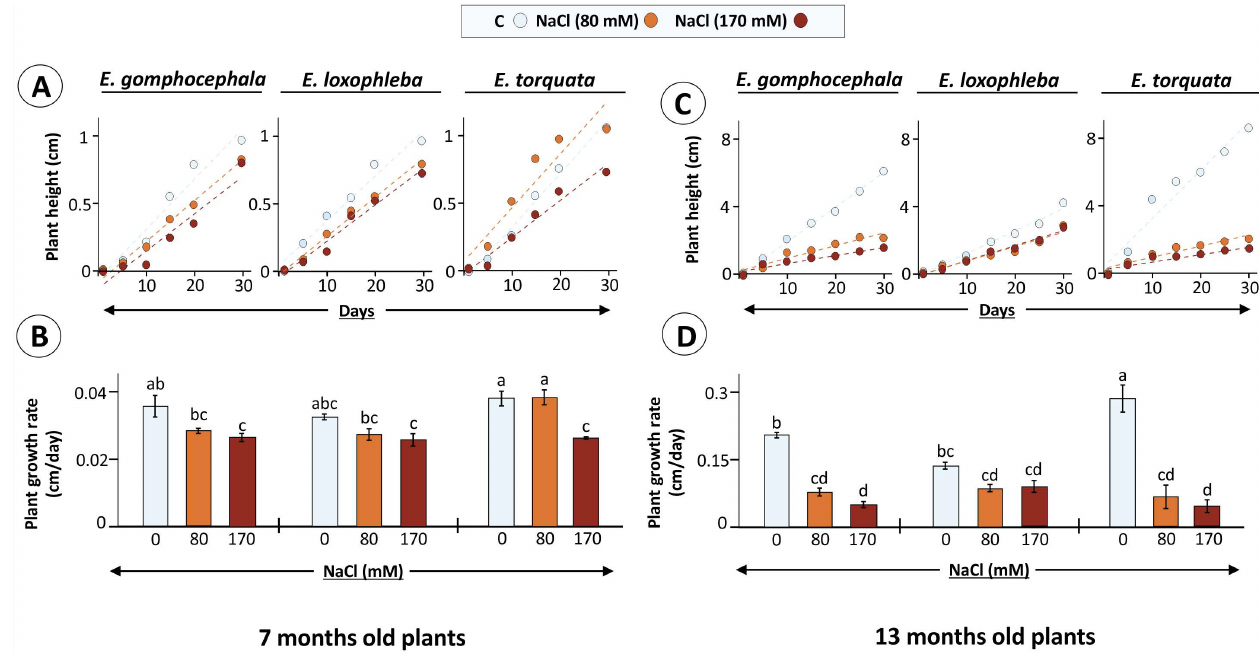
Figure 2. Eucalyptus plant growth as influenced by salt treatment. Eucalyptus species were exposed to NaCl (80 and 170 mM) added to the growth substrate after 6 ( A , B ) or 12 ( B , C ) months after germination and their growth was recorded during next 30 d. In ( B , D ), data are means of plant growth rate ± SE ( n = 3–4, p < 0.05; ANOVA and Tukey’s post-hoc test; bar